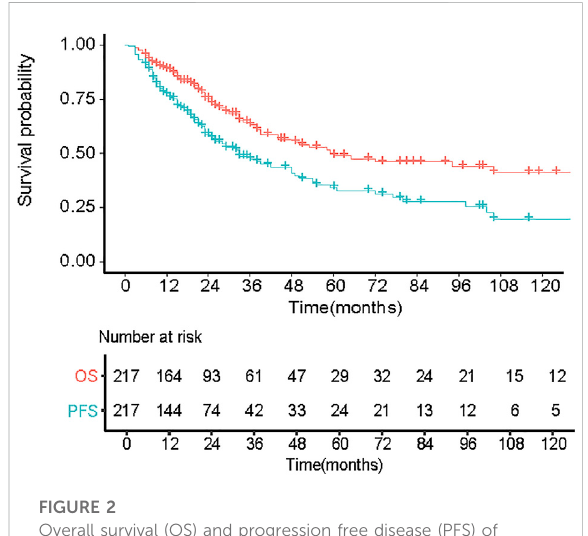
FIGURE 2 Overall survival (OS) and progression free disease (PFS) of 217 patients with primary EMM.